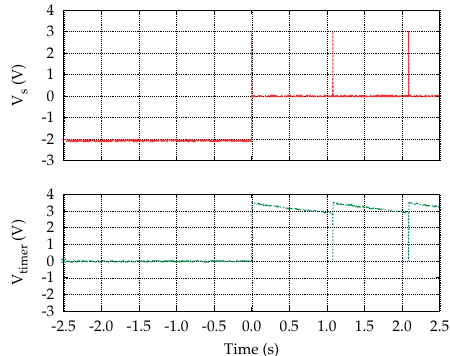
Figure 15. The measured source voltage ( V S ) and timer voltage ( V timer ). The bypass is activated at t = 0 s. The load current is 0.5